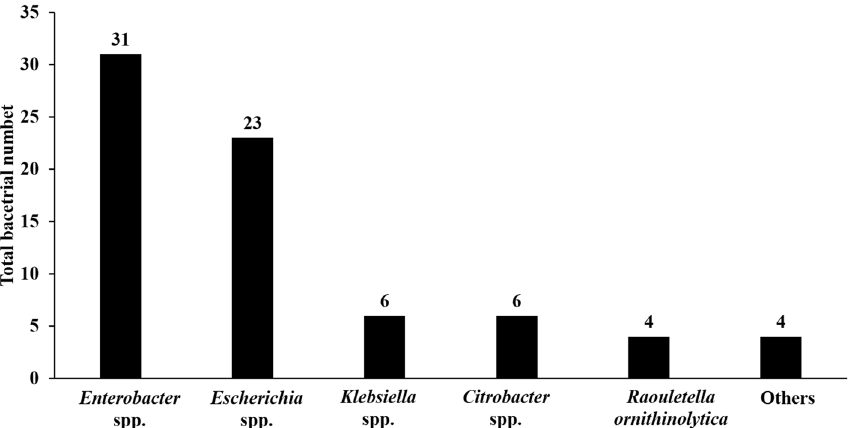
Figure 3. Bacterial isolates identified in this study. Enterobacter species include E. cloacae ( n = 30) and E. hormaechei ( n = 1). Escherichia species include E. coli ( n = 22) and E. fergusonii ( n = 1). Klebsiella species include K. pneumoniae ( n = 4) and K. oxytoca ( n = 2). Citrobacter species include C. braakii ( n = 3), C. freundii ( n = 2), and C. farmeri ( n = 1). Others include S. marcescens ( n = 1), P. septica ( n = 1), L. adecarboxylate ( n = 1), and P. aeruginosa ( n =